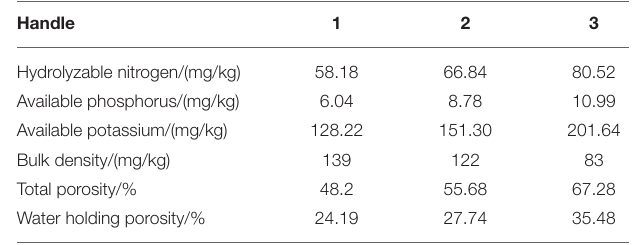
TABLE 4 | Orthogonal experimental design L 9 (cid:0) 3 4 (cid:1) .